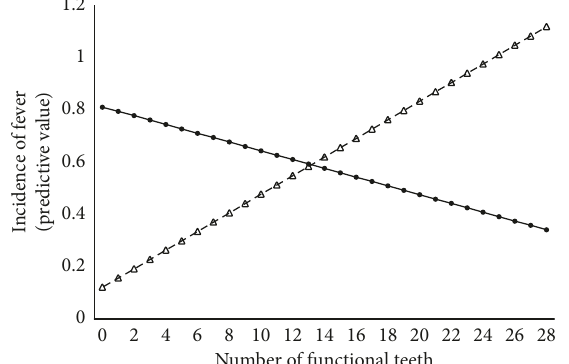
Figure 1: Predictive value of the incidence of fever within one year with or without oral care. The solid line indicates subjects who received oral care, and the dotted line indicates subjects who did not receive oral care. For the subjects who received the oral care program, the predictive value for the incidence of fever decreased with the increase in the number of functional teeth. In contrast, for the subject who did not receive oral care, the predictive values for the incidence of fever increased with the increase of number of functional